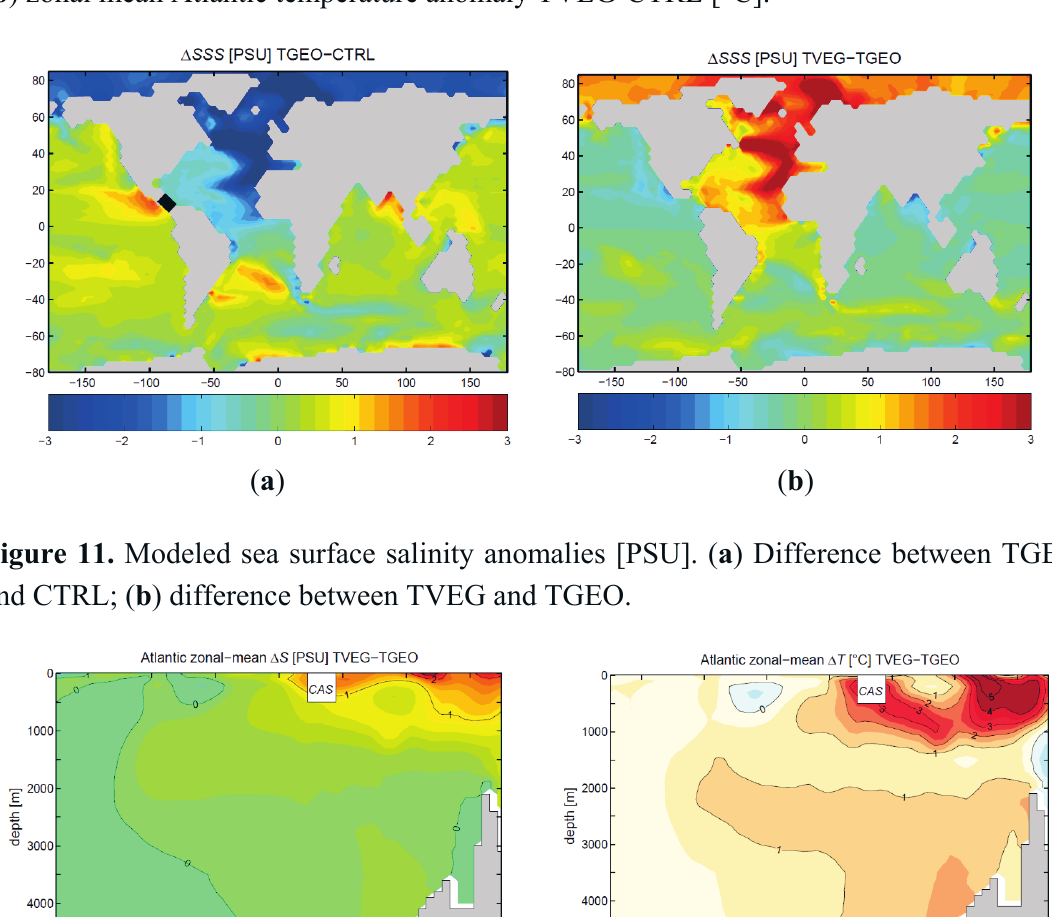
Figure 10. ( a ) Zonal mean sea surface temperature [°C] for CTRL, TGEO, and TVEG; ( b ) zonal mean Atlantic temperature anomaly TVEG-CTRL [°C].